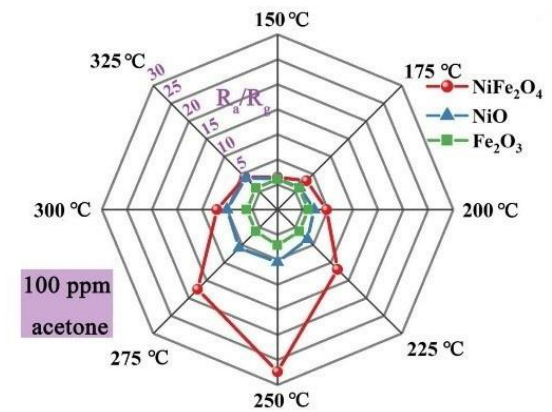
Figure 3. Radar graph showing responses of NiFe 2 O 4 , NiO, and Fe 2 O 3 gas sensors at various temperatures to 100 ppm acetone. [18]. Reprint permission was obtained from Elsevier.